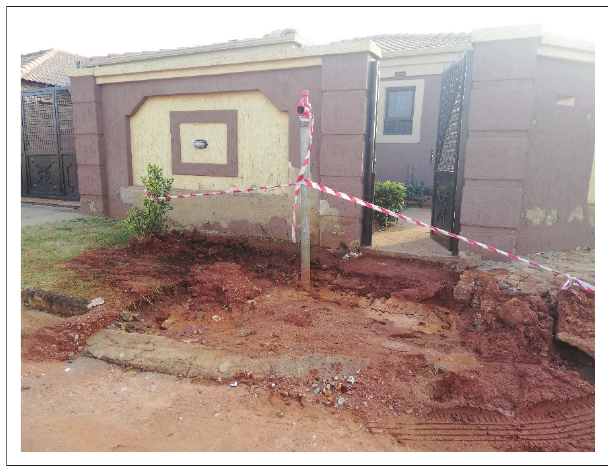
Source : Photo courtesy of Mamorwadi J. Kemp 24 May 2019) FIGURE 4: Damage caused by the leaking emergency tap in Alabama Street, Extension 16 in Protea Glen.